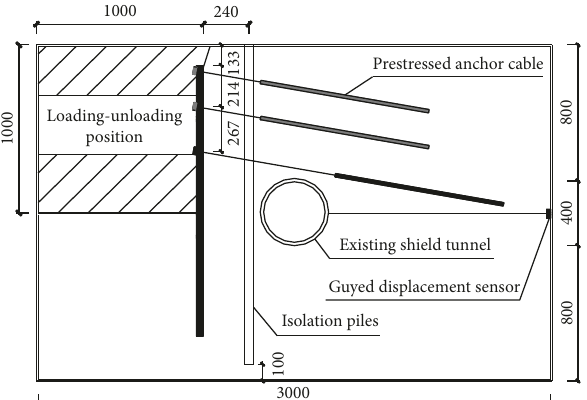
Figure 5: Layout of the support structure and sensor arrangement mode in scheme 1.